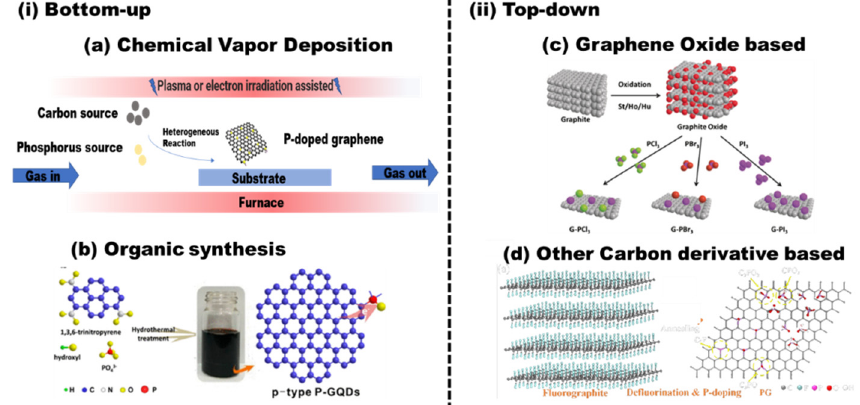
Figure 3. The synthesis routes of phosphorus-doped graphene: ( i ) bottom-up: ( a ) chemical vapor deposition (CVD) and ( b ) organic synthesis; reproduced with permission from [34] © 2022, American Chemical Society. ( ii ) Top-down: ( c ) graphene oxide-based method; reproduced with permission from [35] © 2022 Wiley-VCH VerlagGmbH & Co. KGaA, Weinheim; ( d ) other carbon derivative-based method; reproduced with permission from [36]; copyright © 2022, American Chemical Society.